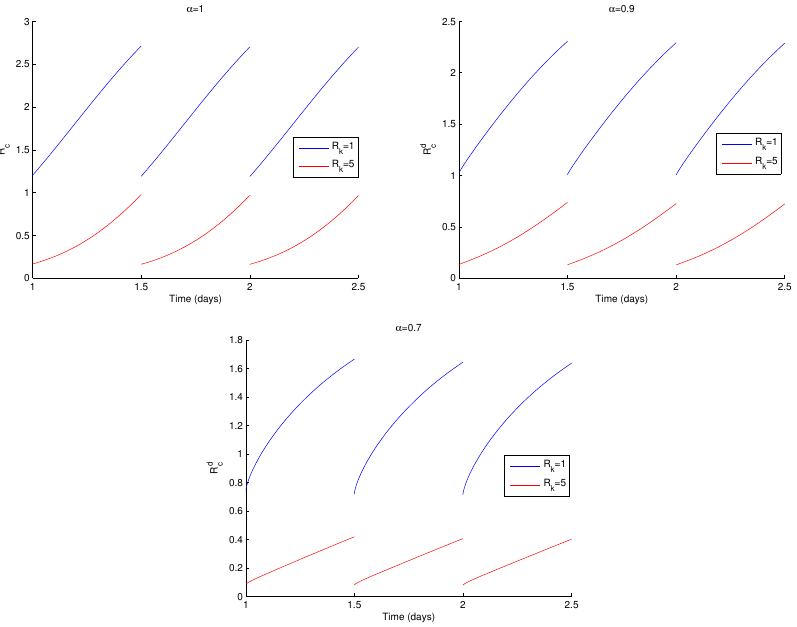
Figure 4. Basic reproduction number R d c of system (1) for α = 1 ( top left ), α = 0.9 ( top right ) and α = 0.7 ( bottom ). Parameter values and initial conditions in the